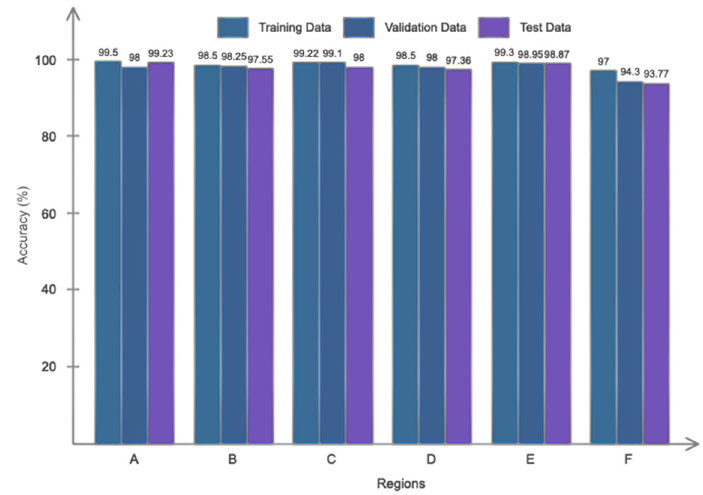
Figure 11. The bar chart diagram of proposed method for all regions. Table 2. The kappa coefficient of the suggested method for all regions.